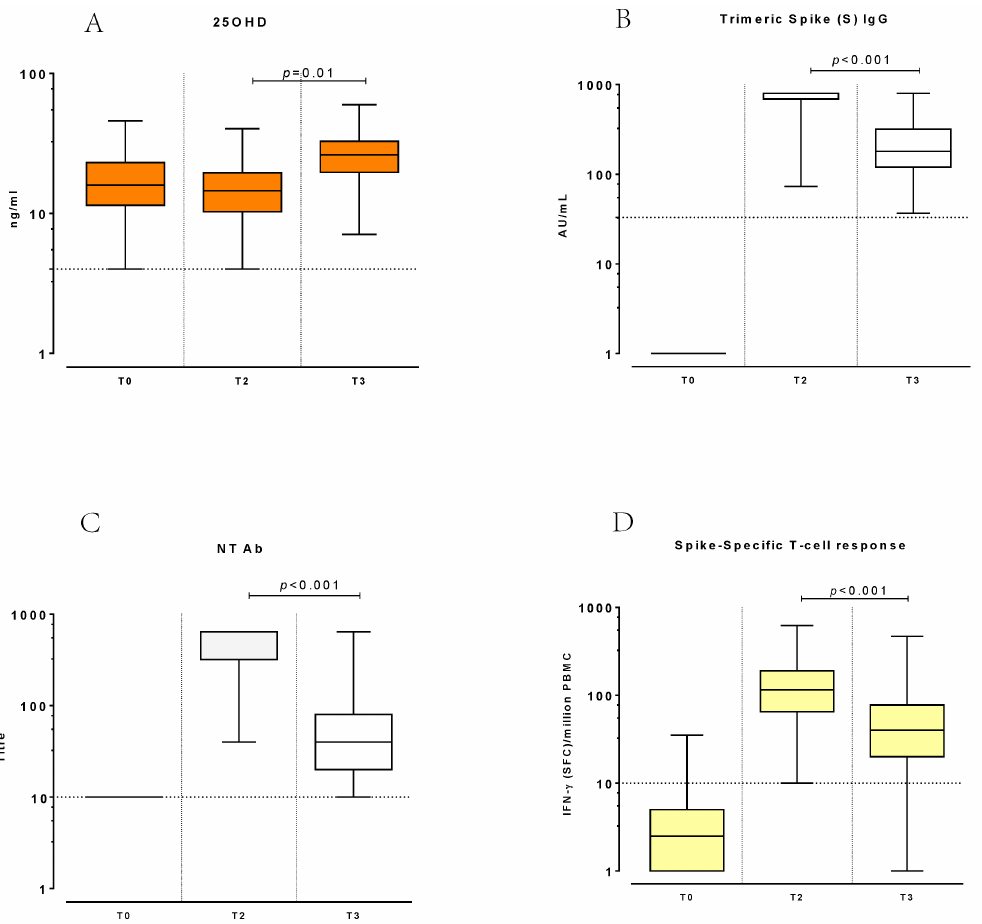
Figure 1. Trend of 25OHD levels ( A ), Trimeric Spike (S) IgG response ( B ), and anti-SARS-CoV-2 neutralizing (NT) antibodies ( C ), and T-cell responses ( D ) measured at T0, T2, and T3. At T2, all subjects developed a positive anti-trimeric-spike (S) response (median level: 800.0 AU/mL; IQR 692–800.0) over the limit of the quantifiable range of the assay. However, we observed a significant decrease in the anti-S response (median level: 176 AU/mL; IQR 119.50–301; p < 0.001) at T3 (Figure 1B). No significant correlation was observed between baseline 25OHD levels and the anti-S response at T2 (Spearman R = − 0.105; CI95% − 0.299–0.096; p < 0.304), but a significant correlation at T3 (Spearman R = 0.233; CI95% 0.037–0.412; p < 0.020) was detected (Figure 2A,B). A similar trend was observed in NT antibodies: at T2, serum NT titres (median NT titre: 320; IQR 320–640) reached significantly higher levels ( p < 0.001) compared to T3 (median NT titre: 40; IQR 20–40) (Figure 1C). At T2, no significant correlation was observed between baseline 25OHD levels and NT titres (Spearman R = − 0.075; CI95% − 0.268–0.124; p = 0.460), while at T3, the 25OHD concentration and NT titres correlated significantly, though weakly (Spearman R = 0.206; CI95% 0.009–0.388; p = 0.040) (Figure